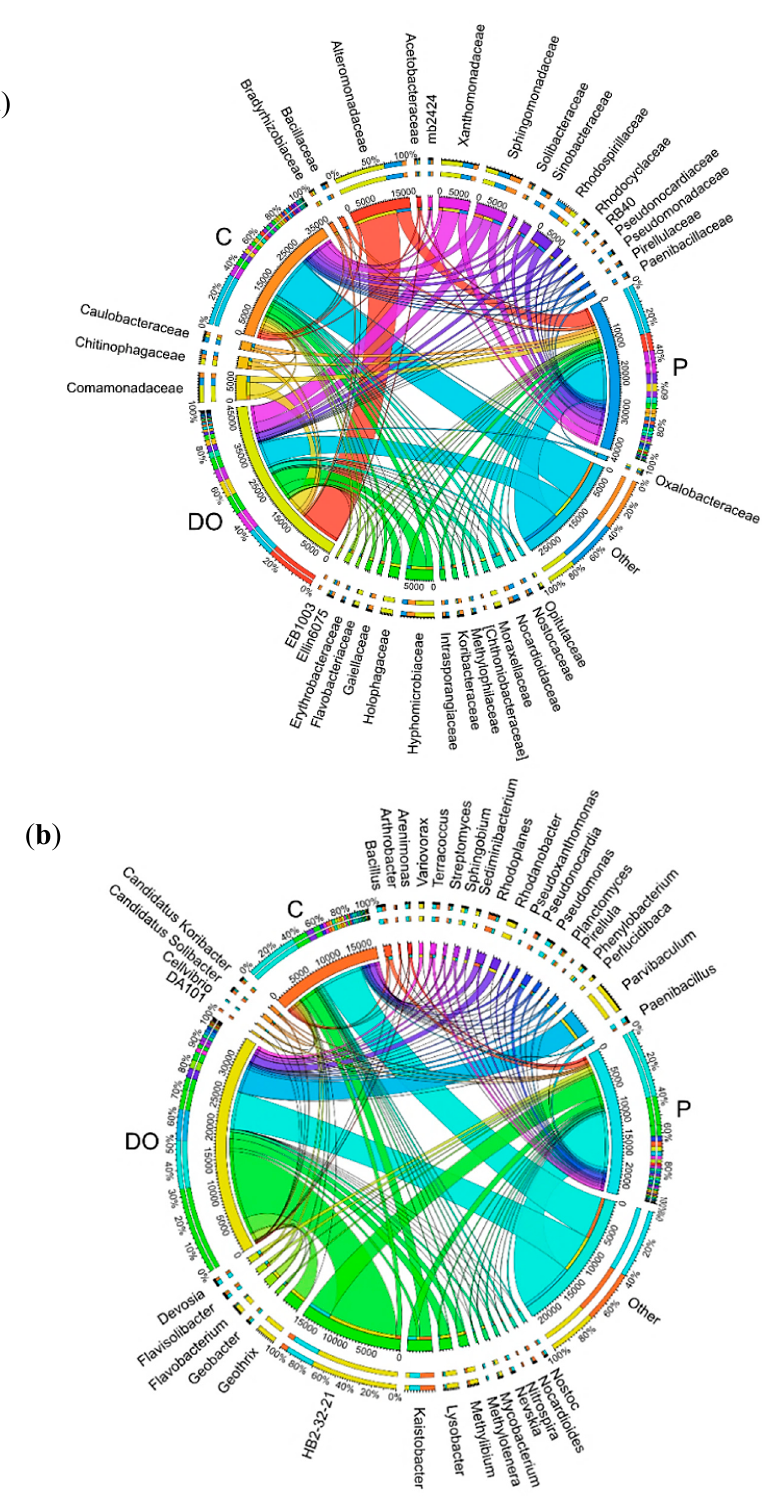
Figure 5. Abundance of bacterial communities at the family level ( a ) and genus level ( b ) in uncontaminated soil (C), soil contaminated with diesel oil (DO) and soil contaminated with unleaded petroleum (P). Abundances < 1% are gathered into the category "other".